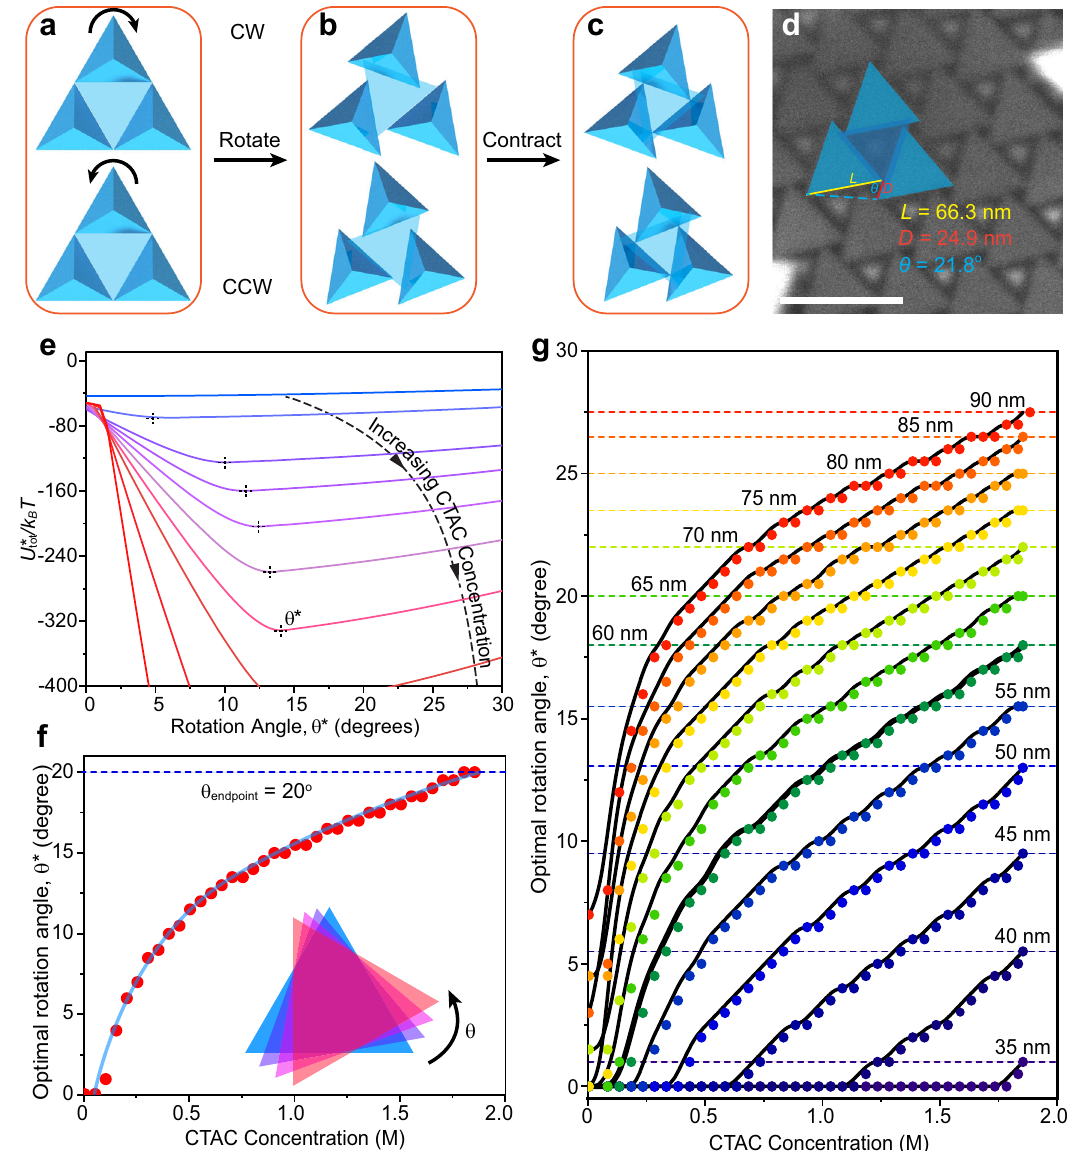
Fig. 4 Particle rotation explains the achiral-chiral phase transition. a Tetrahedra (Td) packed into the achiral (1) structure may b undergo clockwise (CW) or counterclockwise (CCW) rotation to generate chiral enantiomers that c can form a denser lattice with more favorable interparticle attractions. d De fi nition of structural parameters for chiral superlattices including L , the Td edge length, D , the tip offset, and θ , the particle rotation angle. e Model calculations comparing the interaction potential ( U tot * ) as a function of rotation angle. Minimums in the plots de fi ne the optimal rotation angle ( θ * ), which shift to higher values with increasing hexdecyltrimethylammonium chloride (CTAC) concentration. f Optimal rotation angle for L = 66.3 nm edge length Td at different CTAC concentrations showing the predicted value at the endpoint of the assembly process of θ endpoint = 20°. g Calculated optimal rotation angles ( θ * ) of chiral hexagonal assemblies for Td of varying edge length. Scale bar is 100 (Figs. 3 and 4), (E) further Td rotation according to the optimum value ( θ * ) until the fi nal assembly endpoint is reached and samples are dried and static on substrates (Fig. 4).